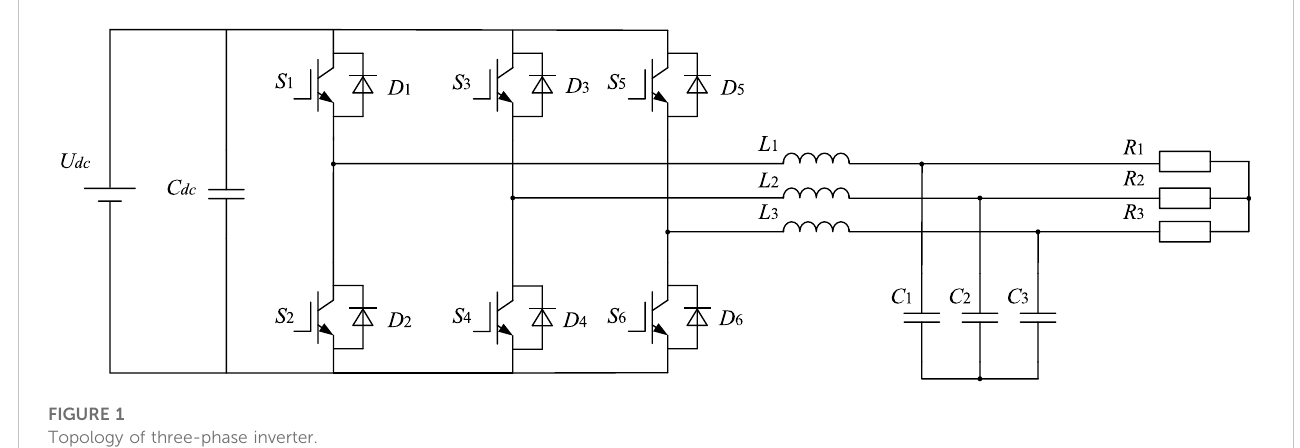
FIGURE 1 Topology of three-phase inverter.